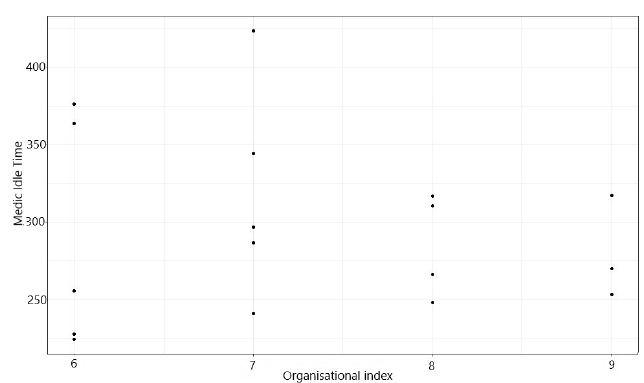
Figure 10. Medic idle time vs. Org index for 12-room